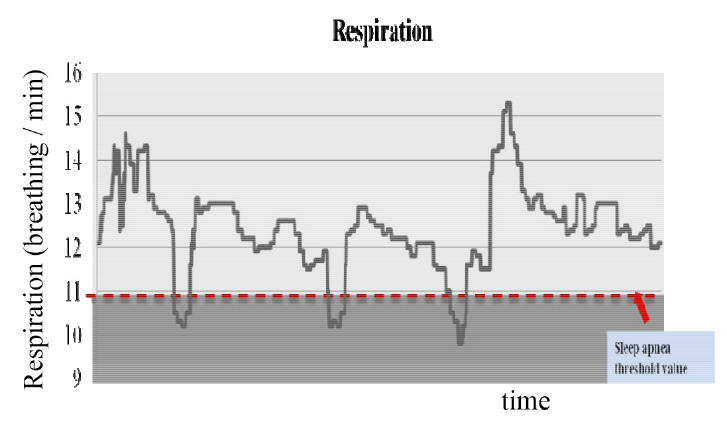
Figure 10. Sleep apnea